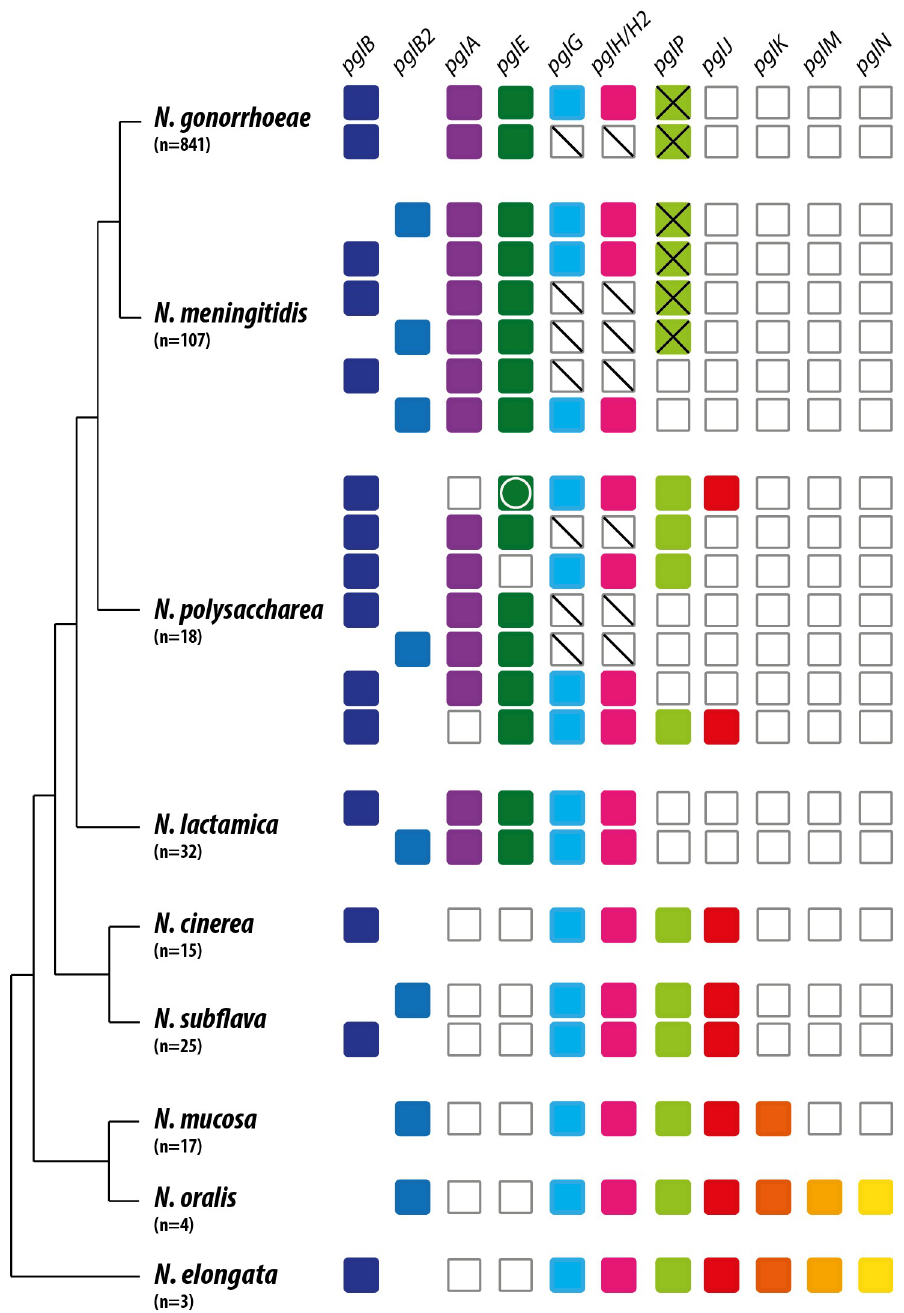
Fig 3. Presence and status of pgl genes shaping glycoform diversity in neisserial species groups. Color boxes indicate gene presence while white boxes indicate gene absence. Boxes with an X denote alleles with ORF-disrupting SNVs and/or CREE insertions while those for pglG and pglH with a diagonal line denote a conserved, inactivating deletion spanning the 3´end of pglG and the 5´end of pglH . The pglE gene with a white circle indicates alleles with the insertion of an IS element. The data are superimposed on a tree of species group relationships established using neighbour-joining phylogeny (modified from that generated in [9]). n = number of strain genomes included. For each species group, patterns shown are ranked by relative abundance from highest (top) to lowest. Strains used are found in S1 Dataset. Note that N . meningitidis CC269 isolates bearing intact ORF pglP genes are not included here. Also, N . meningitidis pglH alleles carrying IS element insertions have been reported by others but such strains were not in the datasets used for this figure [32]. Neisseria PubMLST loci designations are found in S3 Table.